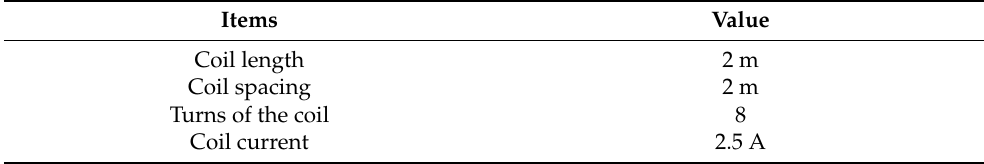
Table 2. The settings of AMCS.